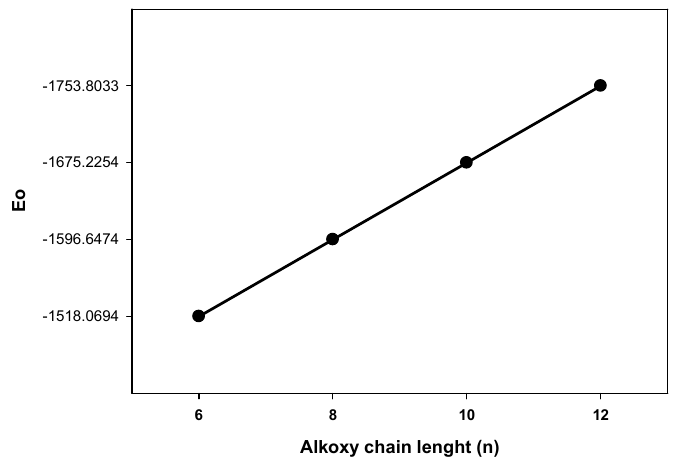
Figure 5. Dependence of the terminal chain length on the thermal energies of series I n .